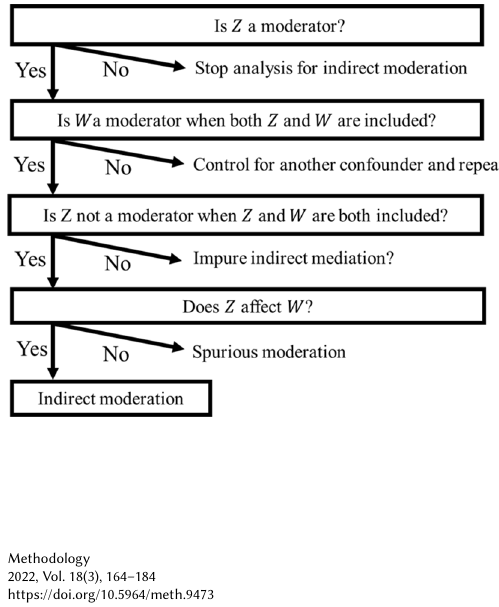
Decision Tree for Assessing Indirect Moderation Using Stepwise Regression Analysis